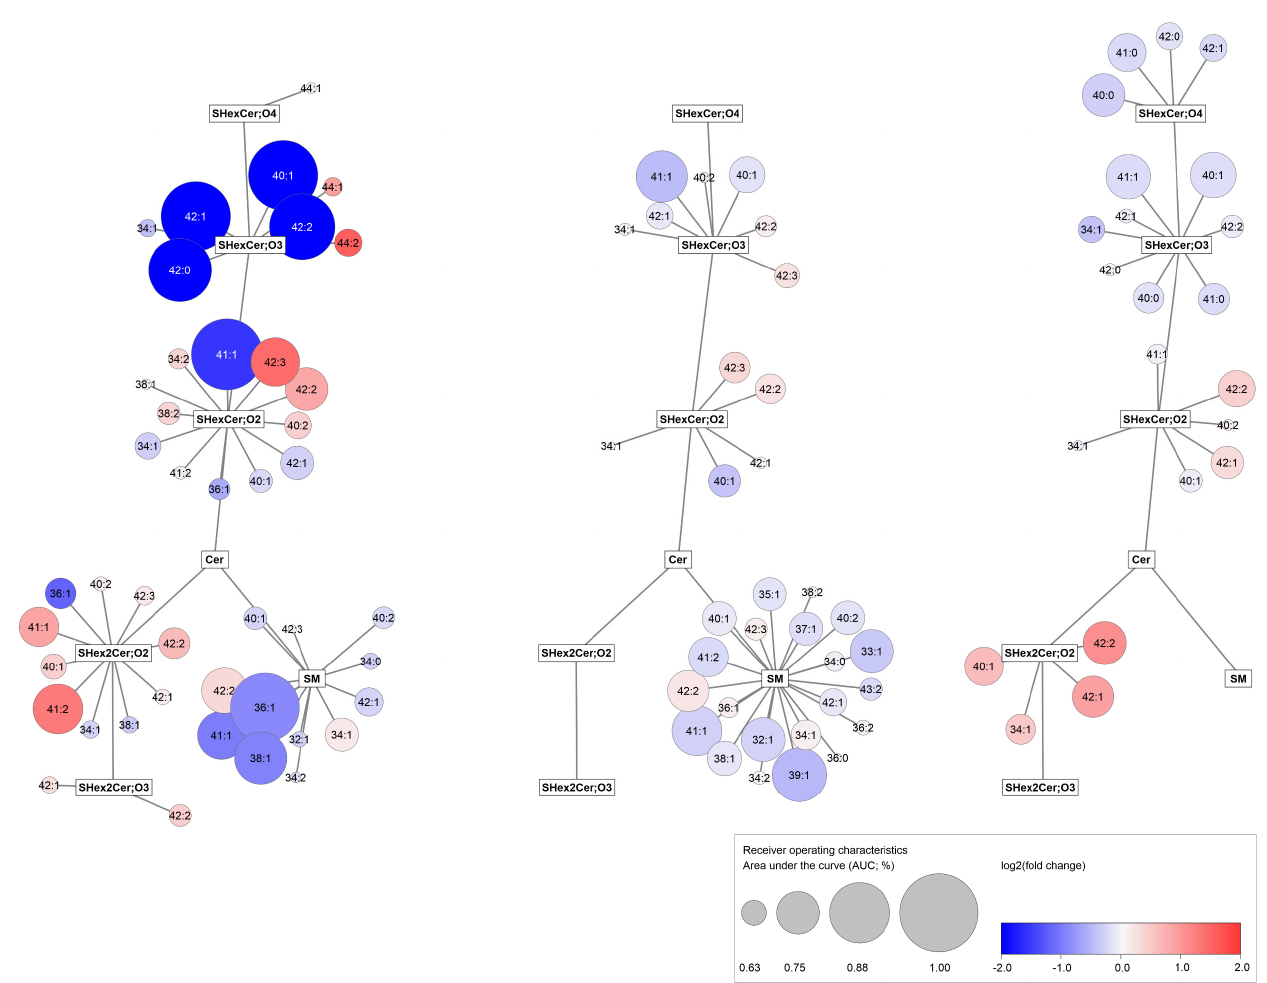
Figure 5. Network visualization of dysregulated lipids in RCC across all three types of samples. The graphs show simplified metabolism of sphingolipids for tissue ( left ), plasma ( middle ), and urine ( right ) samples; Cytoscape software (http://www.cytoscape.org, accessed on 17 December 2021) was used to generate the networks. Circle sizes express the AUC values for binary classifiers constructed for individual lipids (Supplementary Data S2S), while red/blue color saturation represents fold change (T/N).